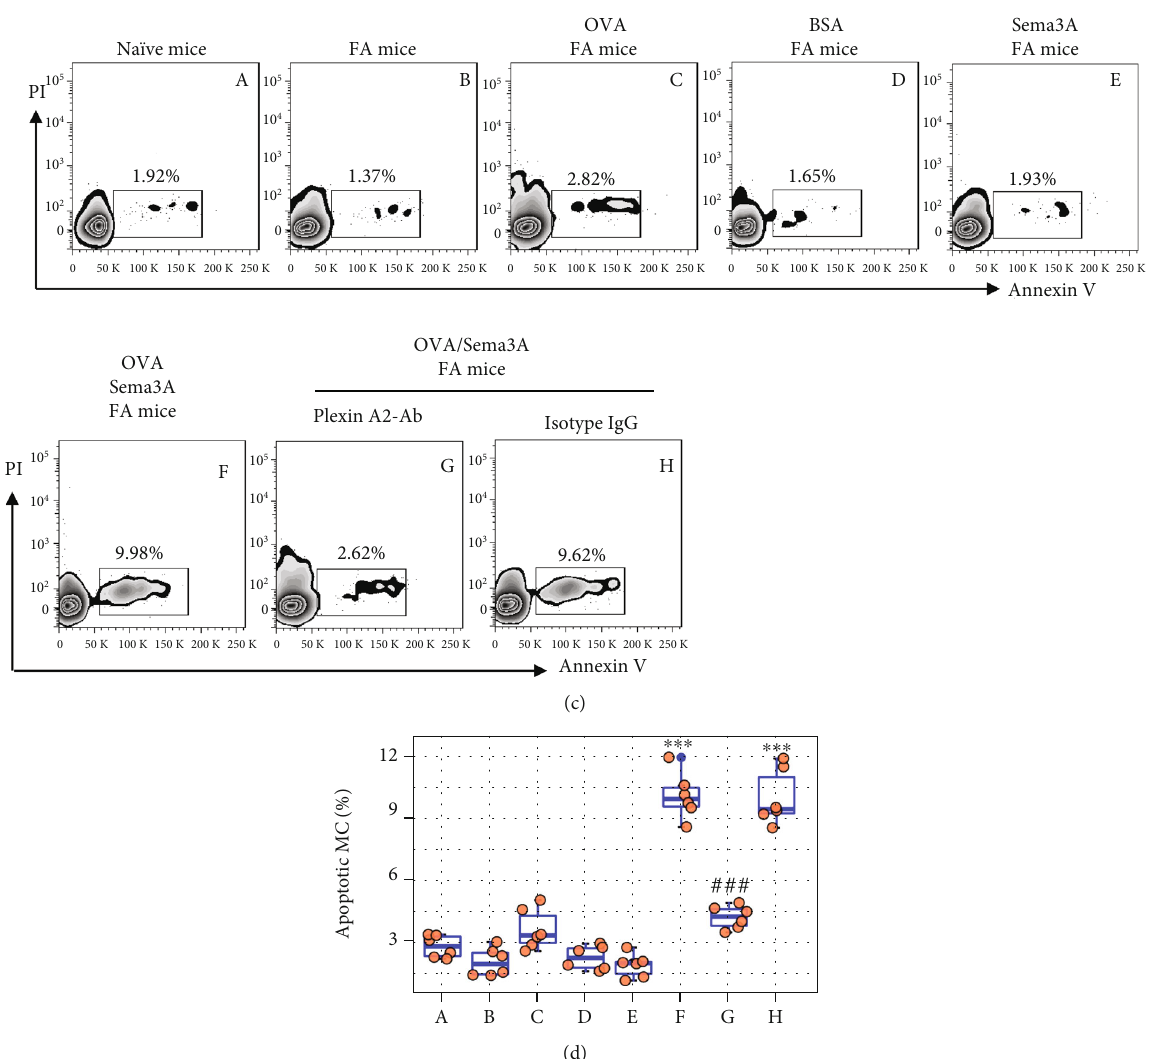
Figure 5: sema3A restores sensitivity to speci fi c antigen-induced apoptosis of sensitized mast cells. (a, b) BMMCs were treated with the procedures denoted above each FCM panel. Gated FCM plots show apoptotic BMMC counts. Boxplots show summarized